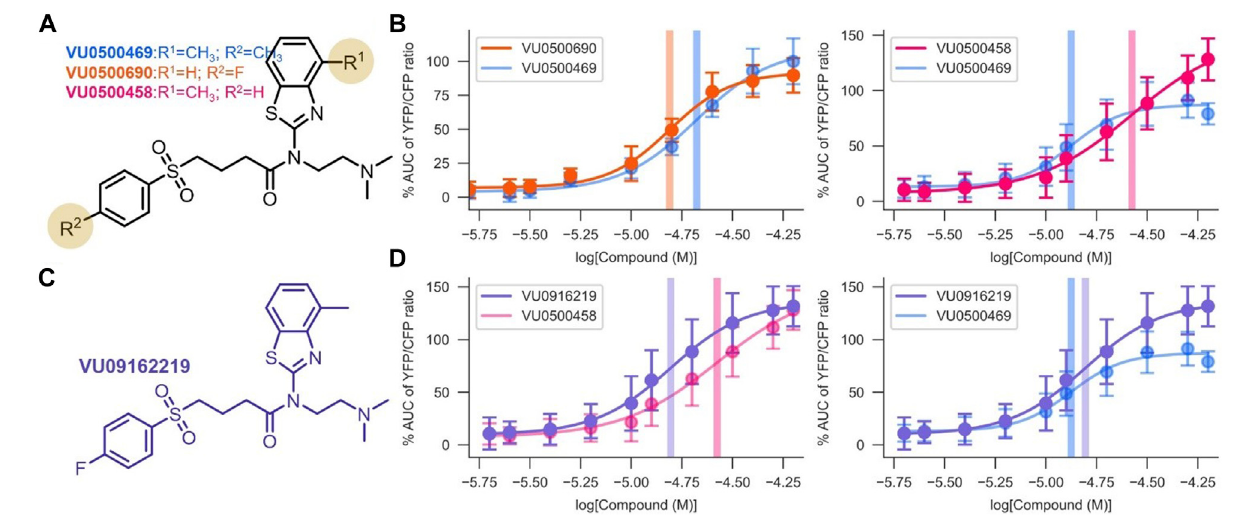
FIGURE 3 | Development of VU0916219, a KCC2 potentiator with improved activity. Experiments conducted at 37 ° C, using the Cl − Flux Assay in HEK-293 cells overexpressing KCC2. Data are normalized to maximum VU0500469 activity being 100%. (A) Structures of the most potent and ef fi cacious VU0500469 analogs. (B) Comparison of VU0500469 dose-response curve to the most potent (left panel) and ef fi cacious (right panel) compounds. (C) Structure of VU0916219. (D) Comparison of VU0916219 to the most ef fi cacious compound (left panel), and VU0500469 (right panel). (n ≥ 6), error bars represent SD.